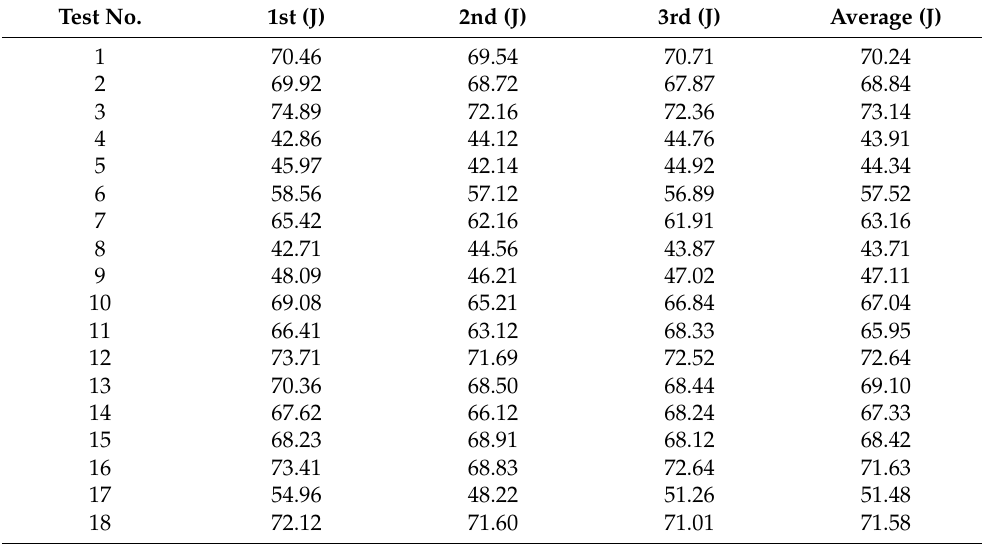
Table 5. Results of Charpy impact test according to fiber laser welding. Test No.